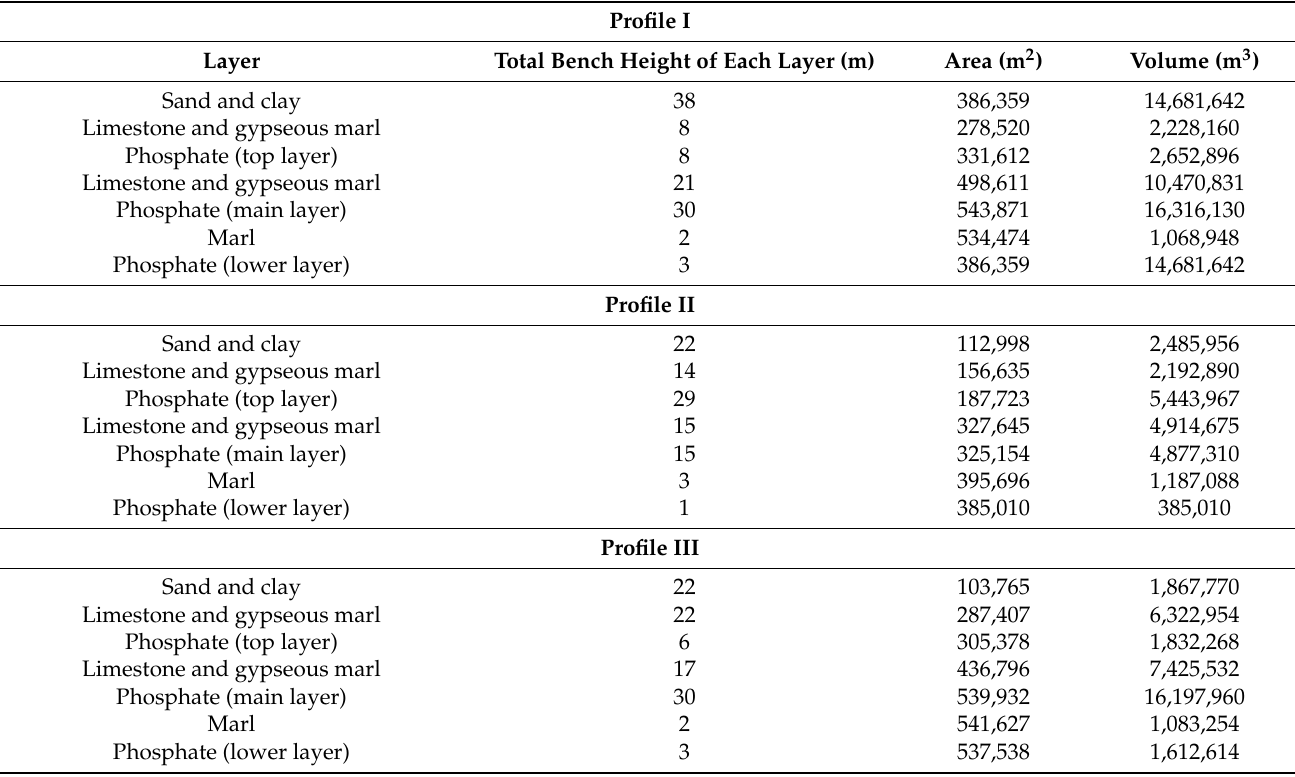
Table 1. The volume removed from the different layers in profiles I, II and III. Profile I